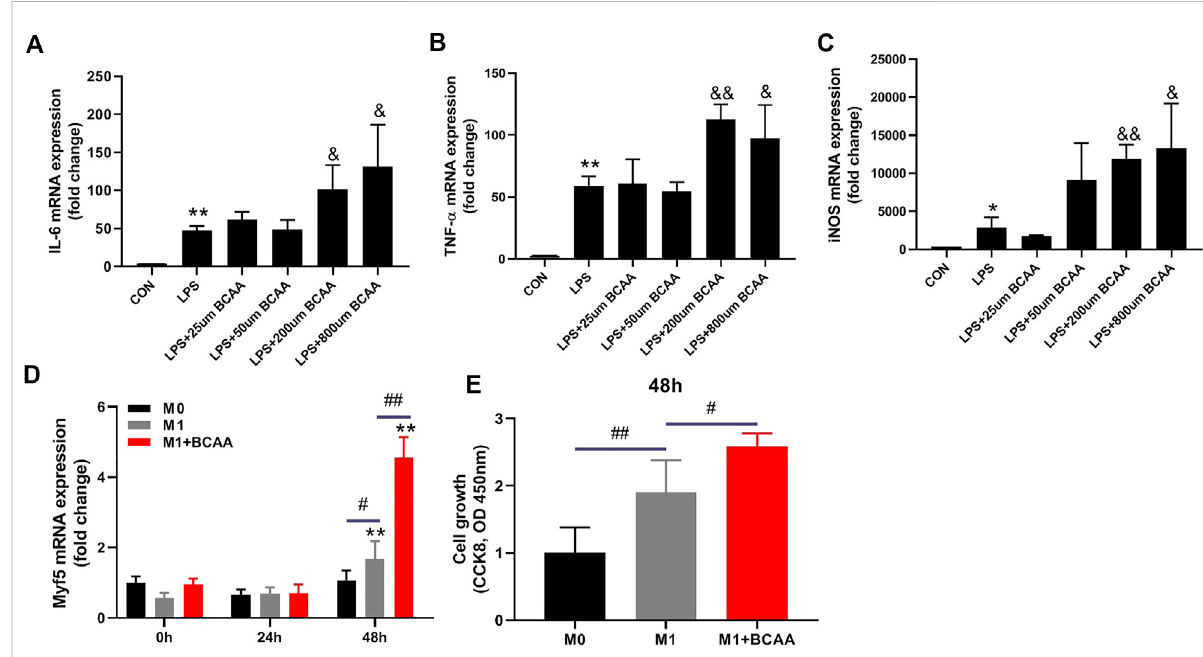
FIGURE 3 BCAA-promoted M1 macrophages enhance the proliferation of SCs. (A – C) The effects of various concentrations of BCAAs on the polarization of M1 macrophages. (D,E) The effect of BCAA (800 μ m)-treated M1 macrophages on C2C12 proliferation. Data are presented as mean ± SEM. * p